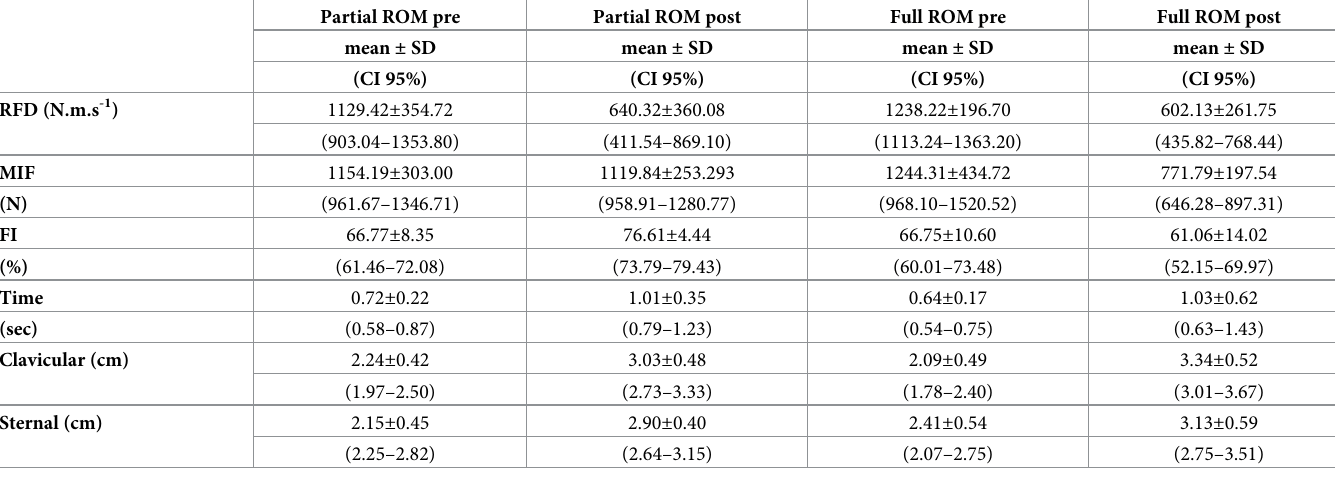
Table 2. Rate of Force Development (RFD), Maximum Isometric Force (MIF), Fatigue Index (FI), Time to maximum isometric force (Time) (sec) and muscle thick- ness in clavicular and sternal portions of pectoralis major in the different exercise